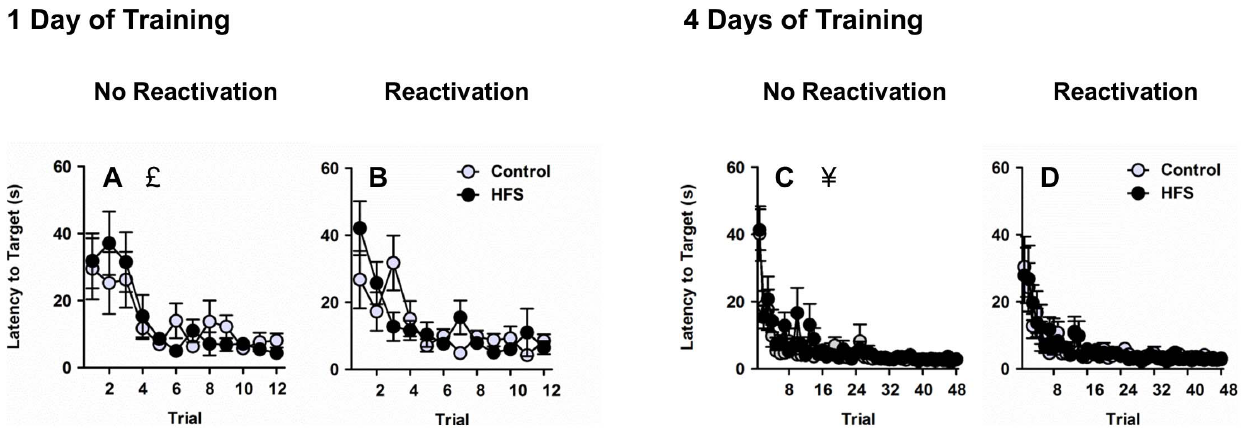
Figure 3. Training. Both rats that underwent 1 day of training ( AB ) and rats that underwent 4 days of training ( CD ) displayed a decrease in latency to reach the hidden platform across trials. £ denotes main effect of trial within 1-day training group (collapsed across reactivation/no reactivation and HFS/control groups), p , .05. ¥ denotes main effect of trial within 4-day training group (collapsed across reactivation/no reactivation and HFS/control groups), p ,